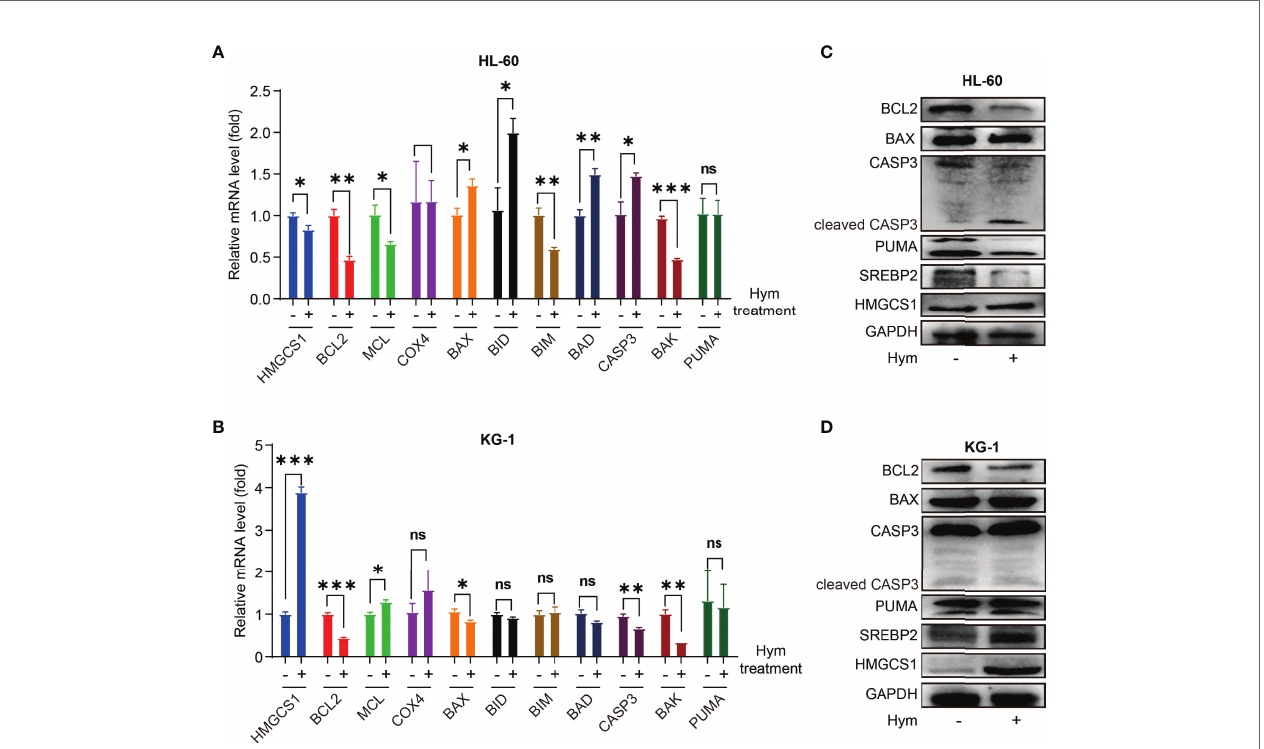
FIGURE 2 | Impact of hymeglusin on the expression levels of apoptosis-related genes. (A, B) The RNA level alterations of important genes involved in apoptosis after hymeglusin treatment in HL-60 (A) and KG-1 cells (B) . (C, D) The protein levels of key apoptosis related genes (BCL2, BAX, PUMA, CASP3 and cleaved CASP3), and SREBP2 after hymeglusin treatment in HL-60 (C) and KG-1 cells (D) . The treatment concentrations were 8 m M and 16 m M for HL-60 and KG-1 cells, respectively. *P<0.05,**P<0.01,***P<0.001. ns, not signi fi